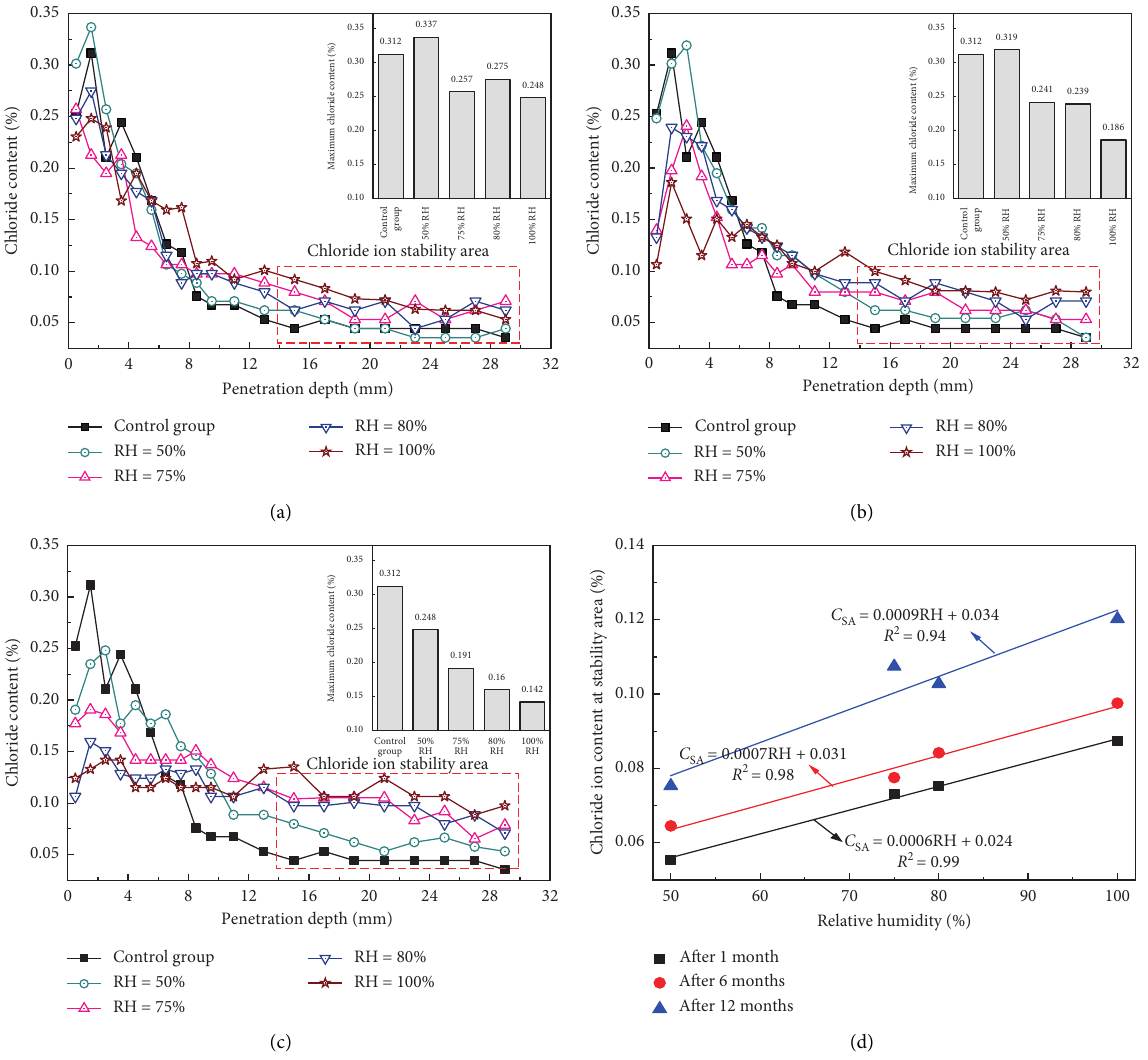
Figure 9: Chloride content curves of concrete after various exposure durations (w/c � 0.5). (a) After 1 month, (b) after 6 months, (c) after 12 months, and (d) relationship. Control group represents that the chloride content was immediately determined after chloride